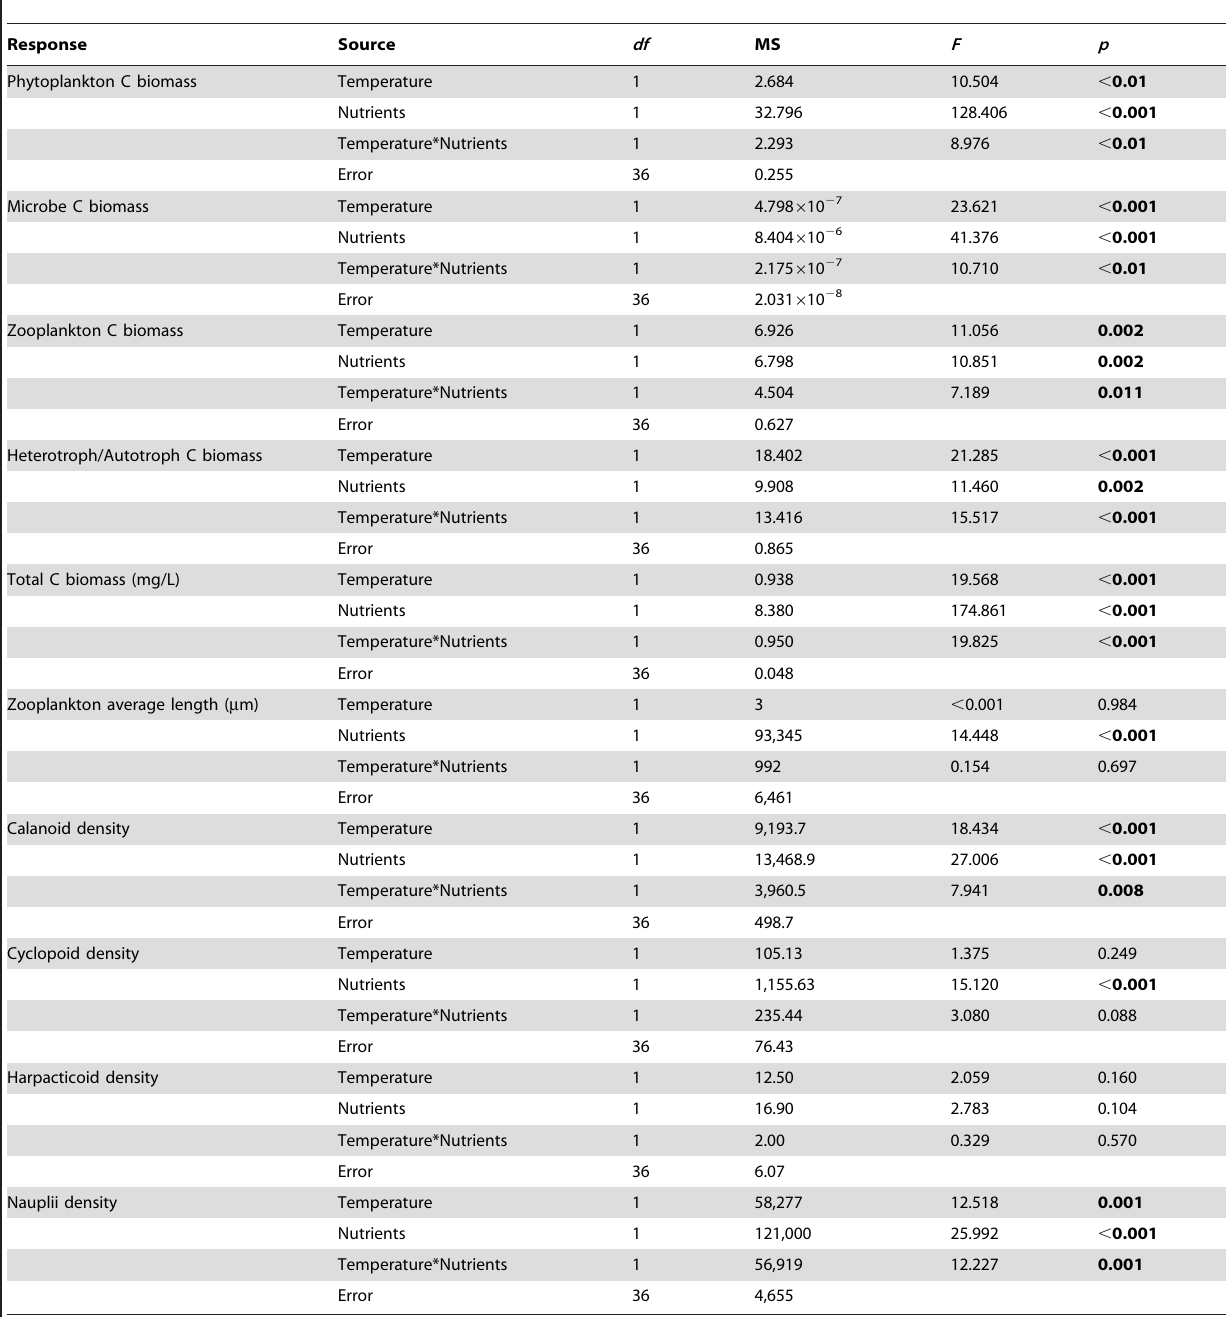
Table 2. Statistical results of two-way ANOVA analyses on the effects of temperature and nutrient levels on biomass standing stocks in an experimental food